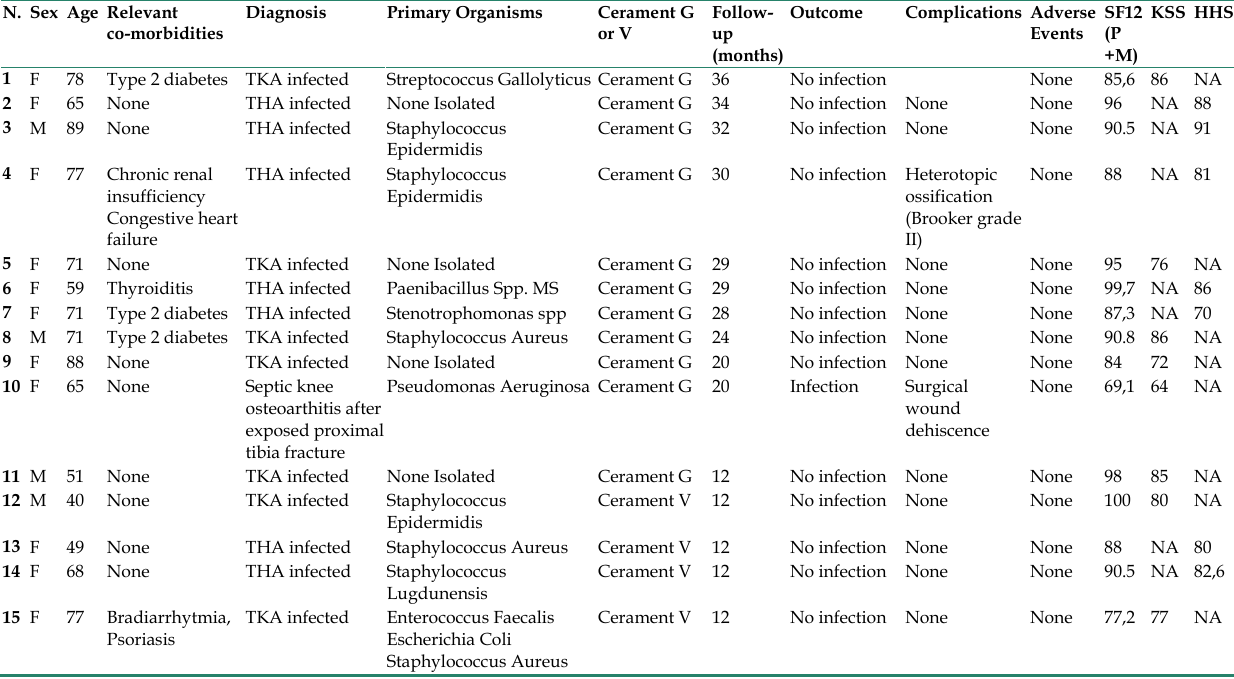
Table 1. Demographics, pre-clinical data, diagnosis, surgical procedures and results of included patients. N. Sex Age Relevant co-morbidities